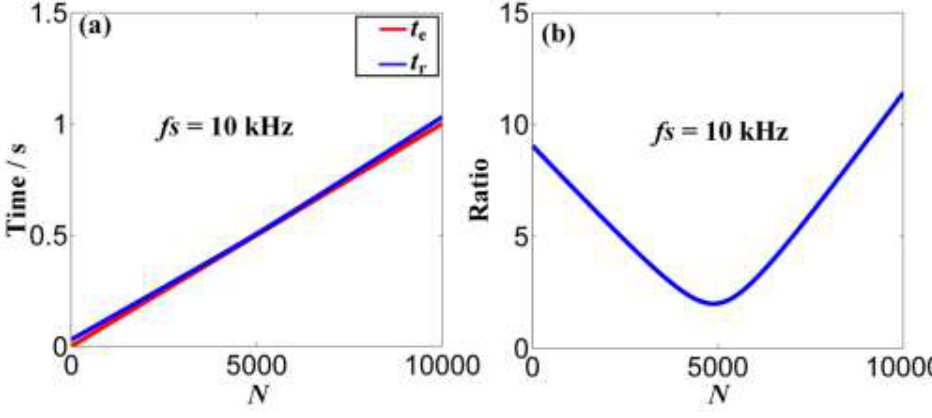
Figure 7. ( a ) Comparison between the scheduled emission time vector and the scheduled reception time vector with the scheduled frequency fs of 10 kHz; ( b ) the amplitude modulation ratio of the effective sampling series with the scheduled frequency fs of 10